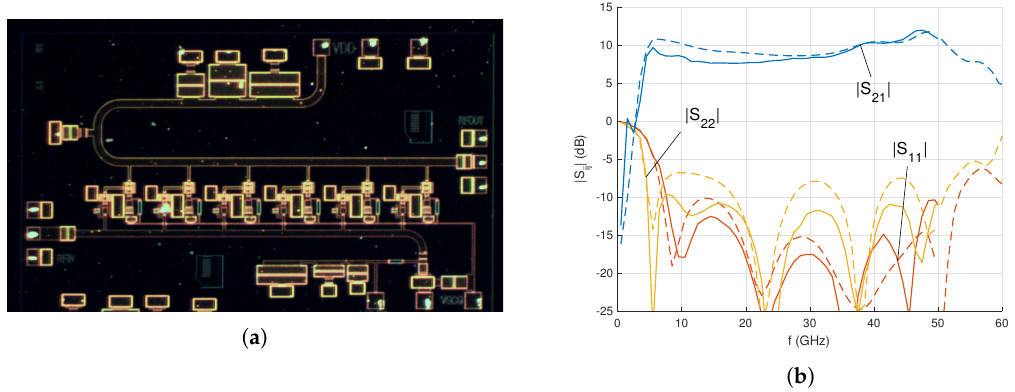
Figure 12. Distributed cascode amplifier with mixed 100 nm/60 nm option: ( a ) Picture. ( b ) Performance. Continuous traces: measurements. Dashed traces: simulations. The nominal operating point is V DD = 12 V, I D = 210